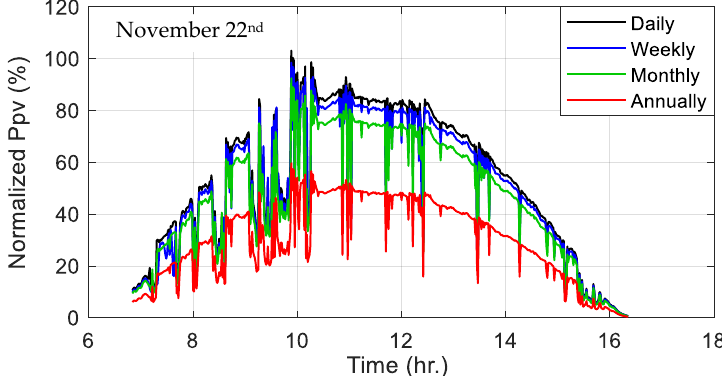
Figure 13. Actual PV data under different cleaning periods (cloudy day).